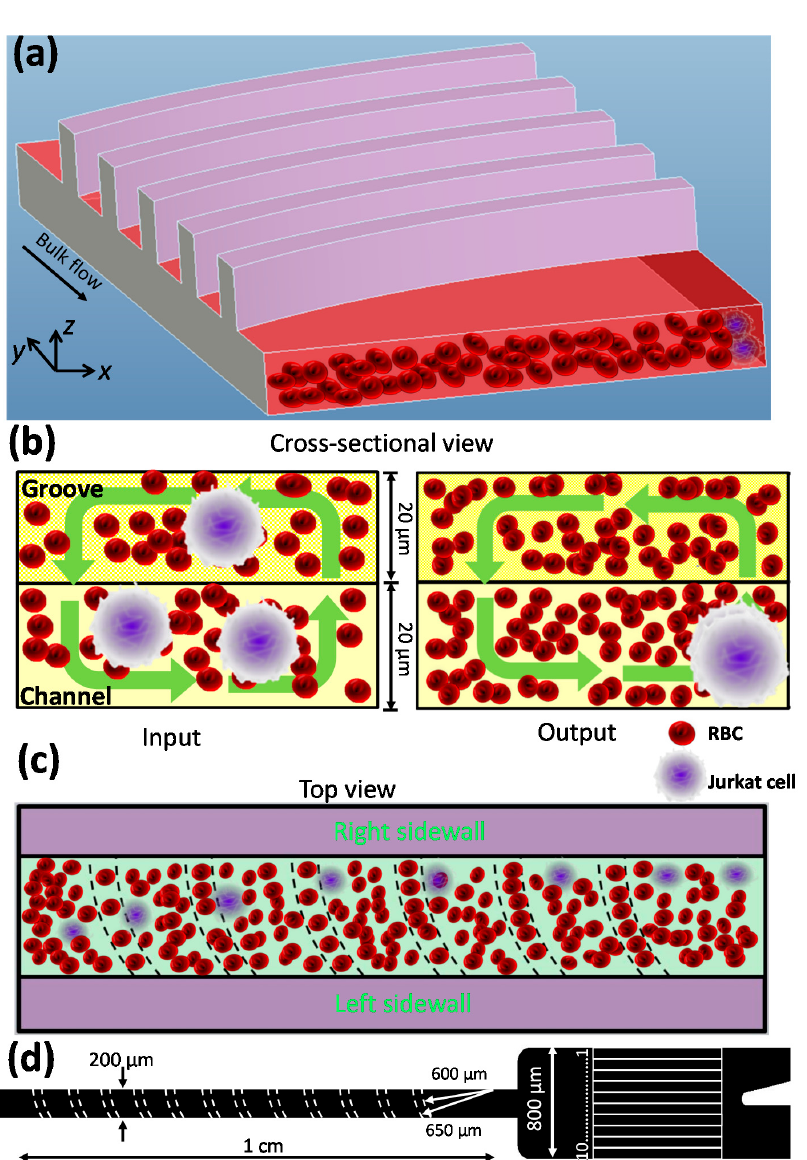
Figure 1. A microfluidic device for Jurkat cell concentration. ( a ) Schematic showing its structure and the spatial distribution of particles. Schematic of the cross-section; ( b ) the top view; and ( c ) the microchannel showing the separation process. The Jurkat cells were distributed randomly at the inlet and migrated to the right sidewall due to a combination of cell margination and secondary flows. ( d ) Optical micrograph images of the groove-based channel.